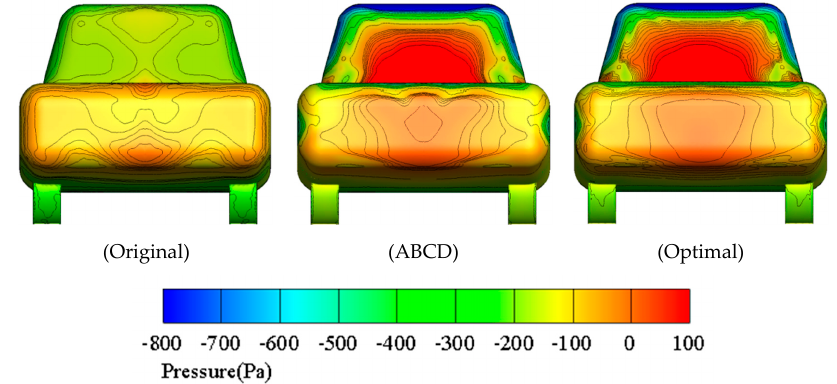
Figure 17. Pressure contour of the vehicle surface.